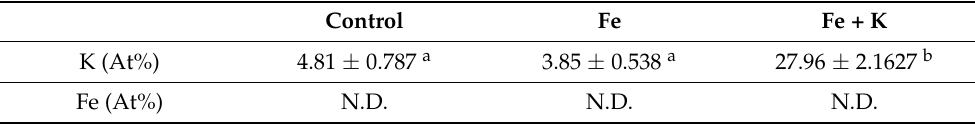
Table 5. K and Fe accumulation in fish gills of all groups presented as At%. Data are expressed as means ± S.E.M ( n = 15). Means in a row followed by different superscript are significantly different ( p > 0.05).